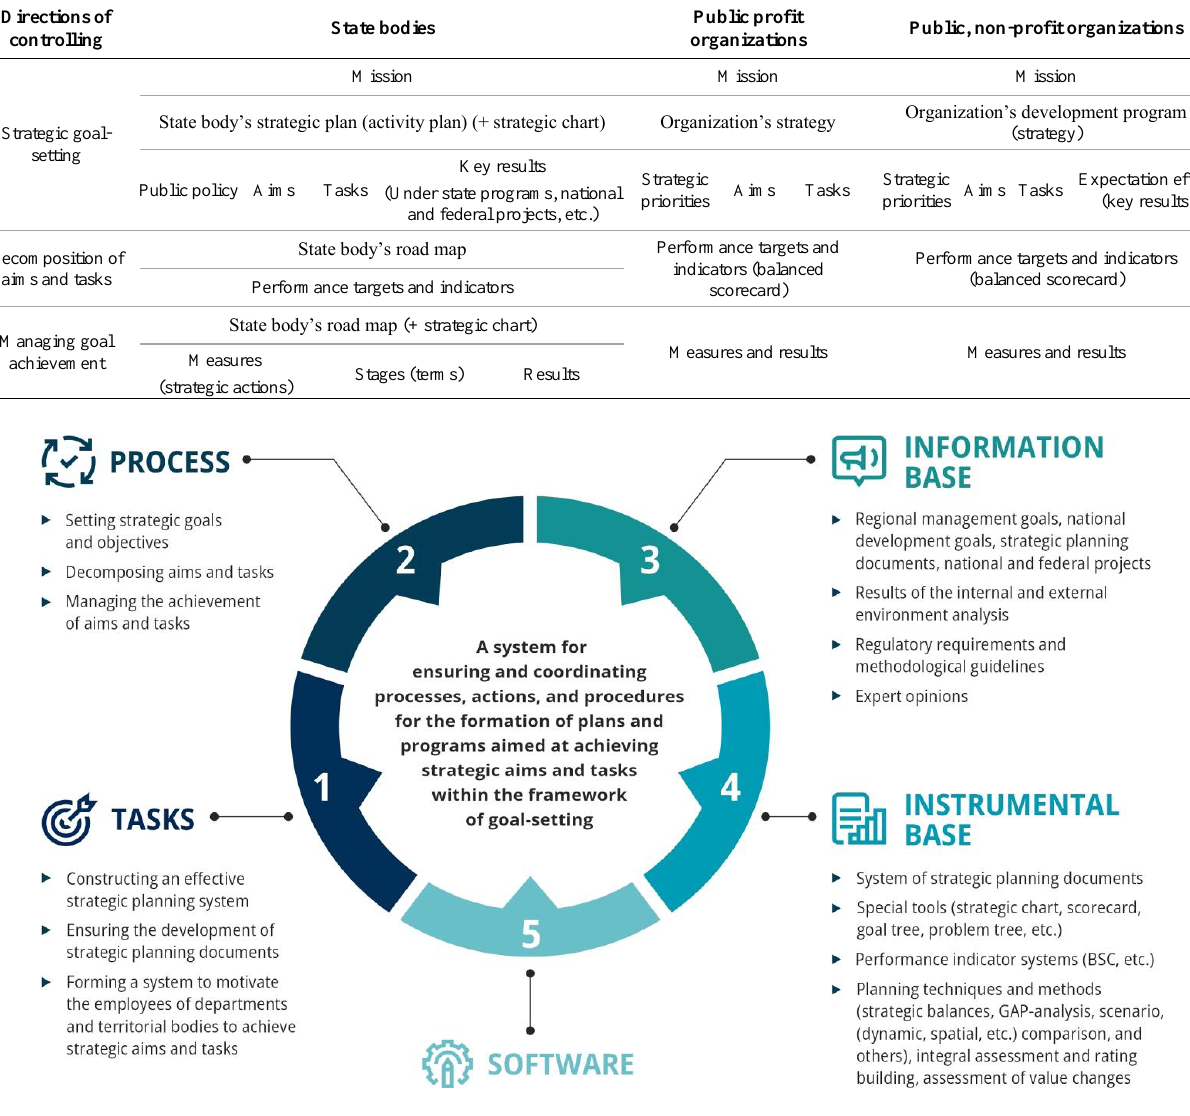
Figure 2. The general controlling scheme of strategic planning for the public sector